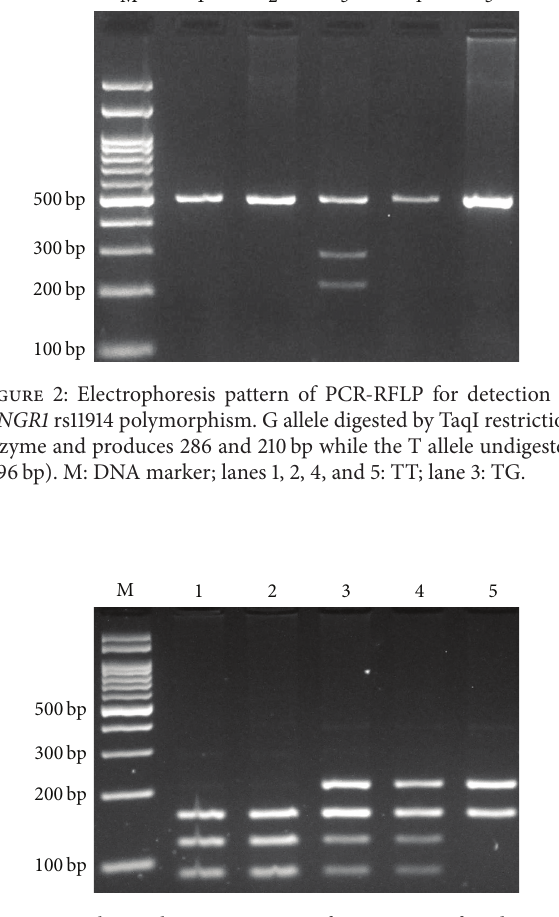
Figure 3: Electrophoresis pattern of PCR-RFLP for detection of IFNGR1 rs7749390 polymorphism. The 366-bp PCR product digested by BstC8I. C allele produces 87, 121, and 158bp, while the